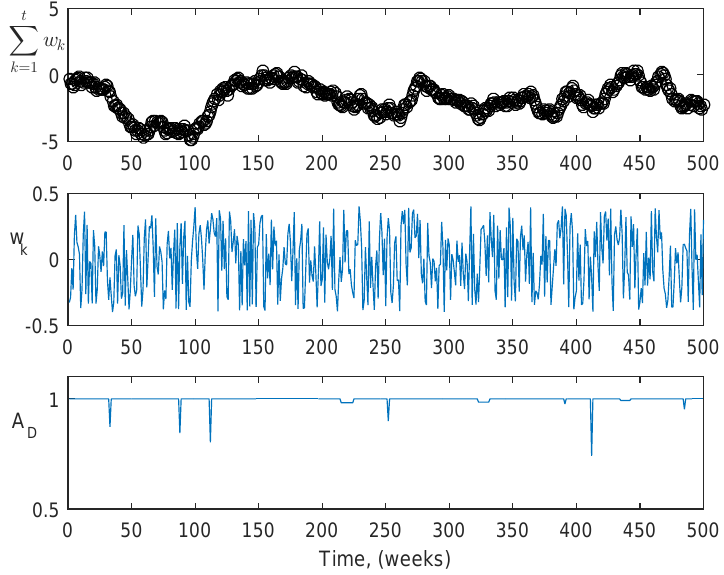
Figure 10. Uncertainty in the PK/PD based simulations: uniform uncertainty plus acute disturbance.